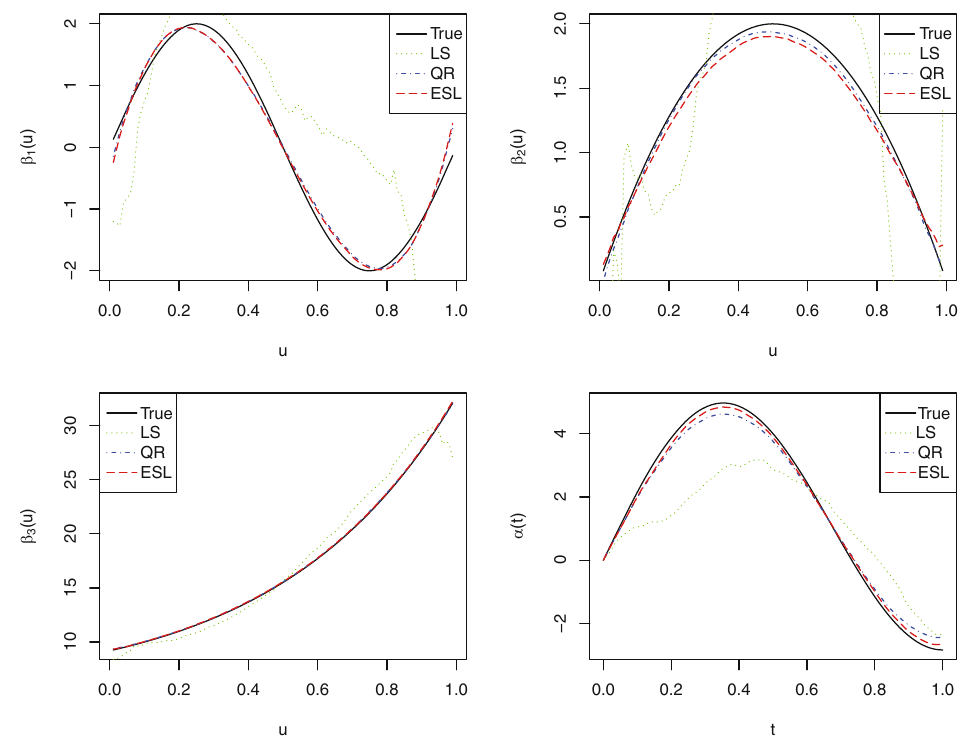
, = j 1, 2, 3 and ( ) α t when ε ~ Cauchy and = n 100 j